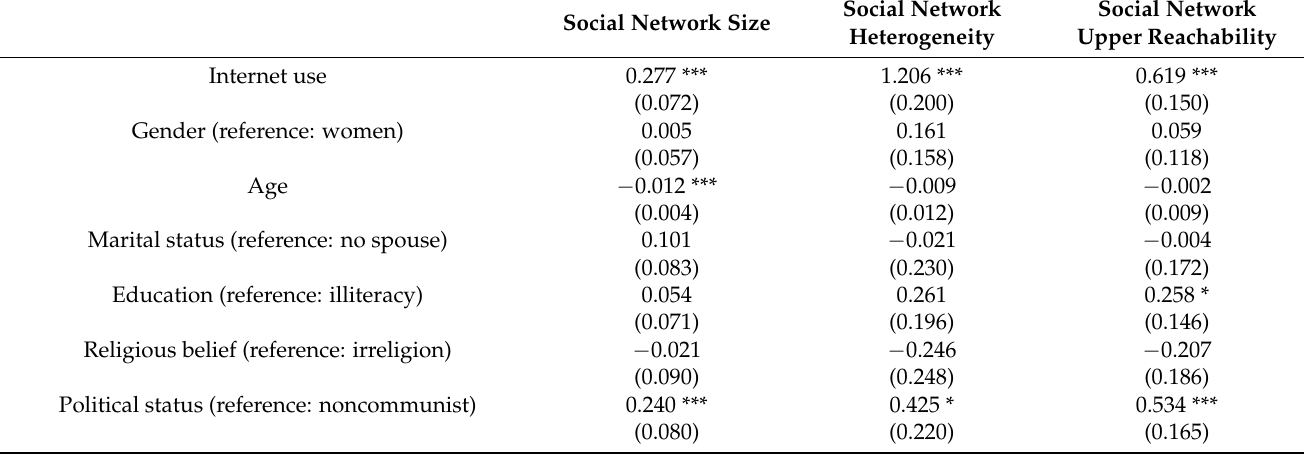
Table 2. Regression analysis of the influence of Internet use on the social networks of the